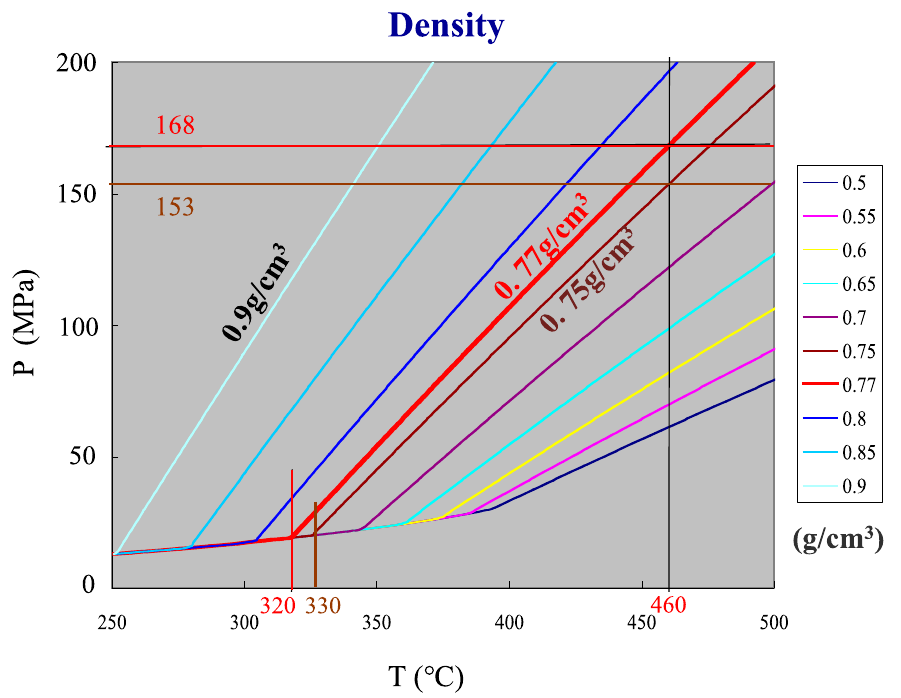
Figure 9. Isochors (lines of equal density) for the Takatori fluid. The density (g/cm 3 ) of the fluid is calculated as a function of temperature and pressure assuming a CO 2 mole fraction of 0.05 [38] and NaCl-equivalent concentration of 9 wt.% [28] for the ternary system of H 2 O–CO 2 –NaCl based on [36,37]. See details in text.